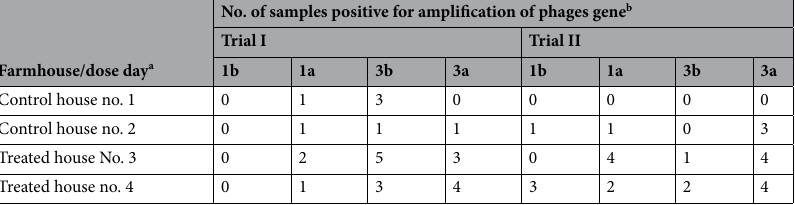
No. of samples positive for amplification of phages gene b Farmhouse/dose day a